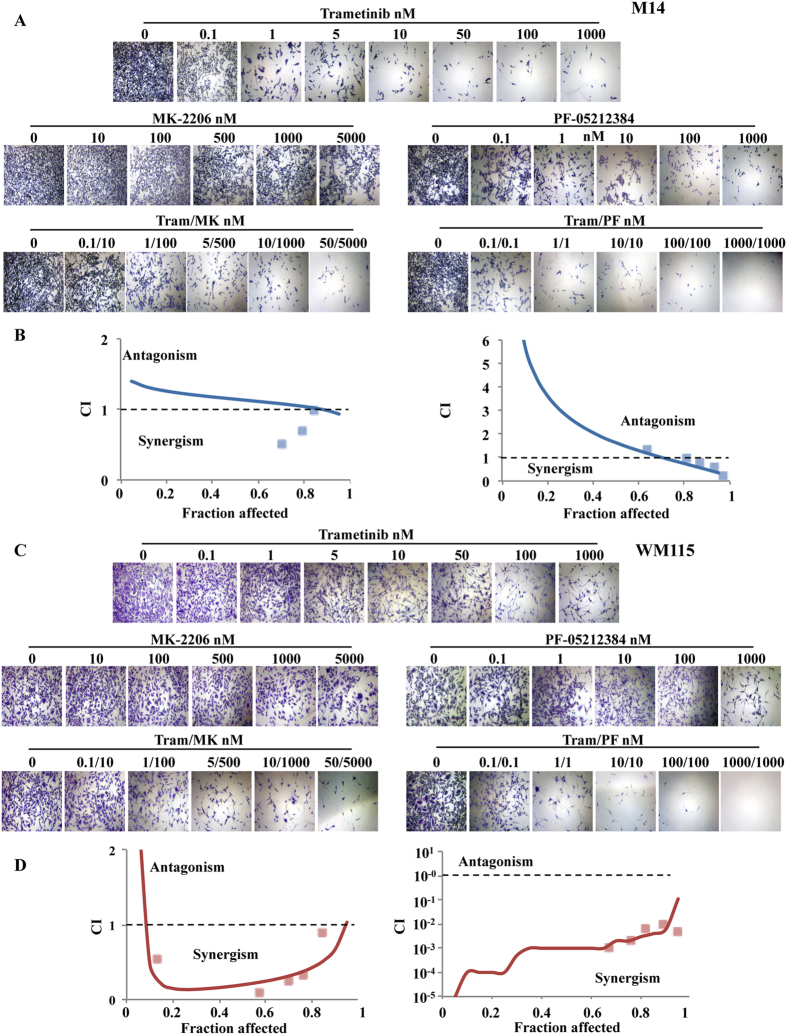
PTEN status affects response to MEK inhibition in combination with either AKT or double PI3K/mTOR inhibition.(A,C) M14 (PTEN-competent, A) and WM115 (PTEN-loss, C) cells were exposed to increasing concentrations of Trametinib (0.1–1000 nM) and either the allosteric AKT inhibitor MK-2206 (10–5000 nM) or the double PI3K/mTOR inhibitor PF-05212384 (0.1–1000 nM); combination experiments were performed using a fixed dose-ratio design using a 1:100 and 1:1 ratio, for Trametinib/MK-2206 and Trametinib/PF-05212384 combinations, respectively. Cells were exposed to treatments for 72 h and cell viability was assessed by Crystal violet assay (representative microscopic fields photographed are shown). Results of one experiment representing three independent experiments performed with superimposable results are shown. (B,D) CI were calculated by conservative isobologram analysis for experimental data and plotted against the fraction affected.